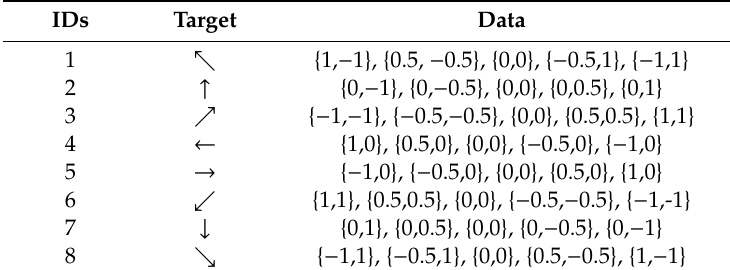
Table 1. Details of eight recognition targets.